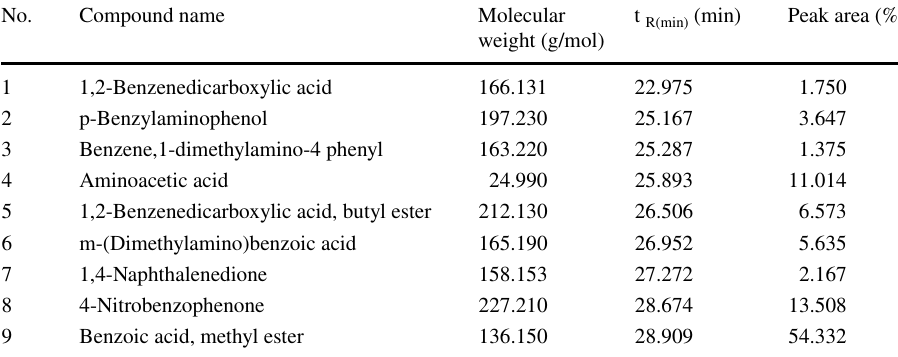
Retention time ( t